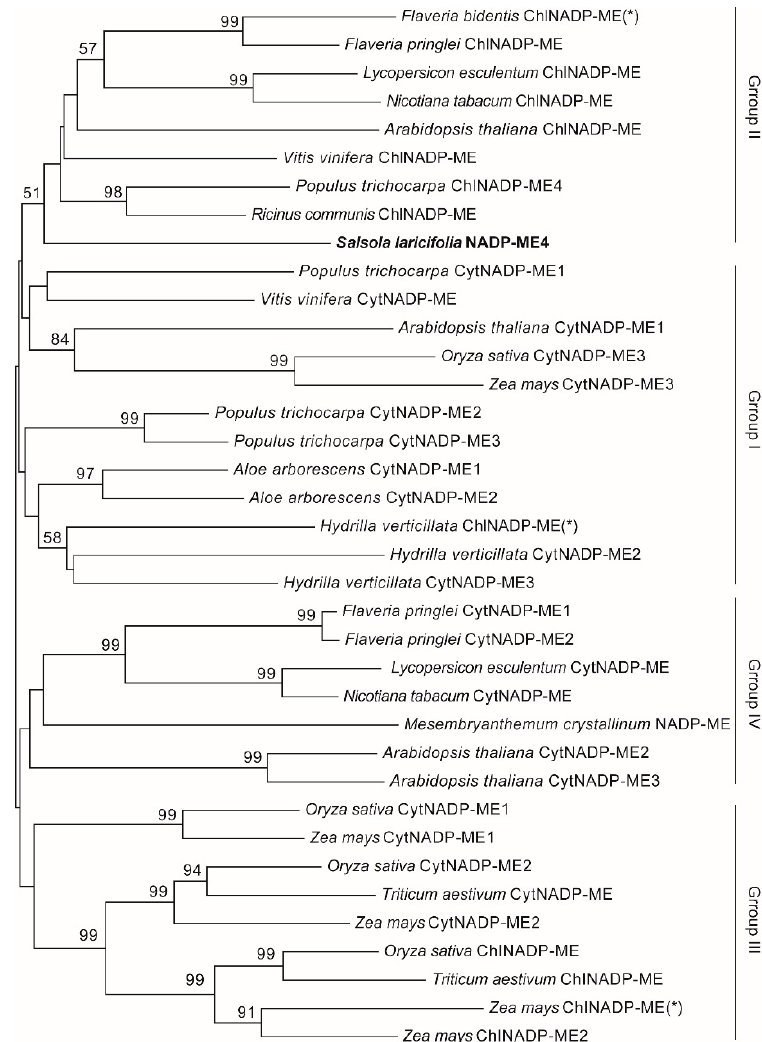
Figure 1. Phylogenetic analysis of SaNADP-ME4 and other plant NADP-MEs via the neighbor joining method using MEGA 6.0 software. All plant NADP-MEs were classified into four groups: Group I (cytosolic eudicot types), Group II (plastidic eudicot types), Group III (monocot types), and Group IV (found in both eudicots and monocots). The C 4 photosynthesis isoforms are marked with (*). Cyt, cytosolic; Chl, chloroplastic. The GenBank accession numbers and sources of the plant NADP-ME s are as follows: Aloe arborescens (CytNADP-ME1, BAA24950.1; CytNADP-ME2, BAA74735.1), Arabidopsis thaliana (CytNADP-ME1, AT2G19900.1; CytNADP-ME2, AT5G11670.1; CytNADP-ME3, AT5G25880.1; ChlNADP-ME, AT1G79750.1), Flaveria bidentis (ChlNADP-ME, AAW56450.1), Flaveria pringlei (CytNADP-ME1, AAK83073.1; CytNADP-ME2, AAK83074.1; ChlNADP-ME, P36444.1), Hy- drilla verticillata (ChlNADP-ME, AY594687; CytNADP-ME2, AY594688; CytNADP-ME3,